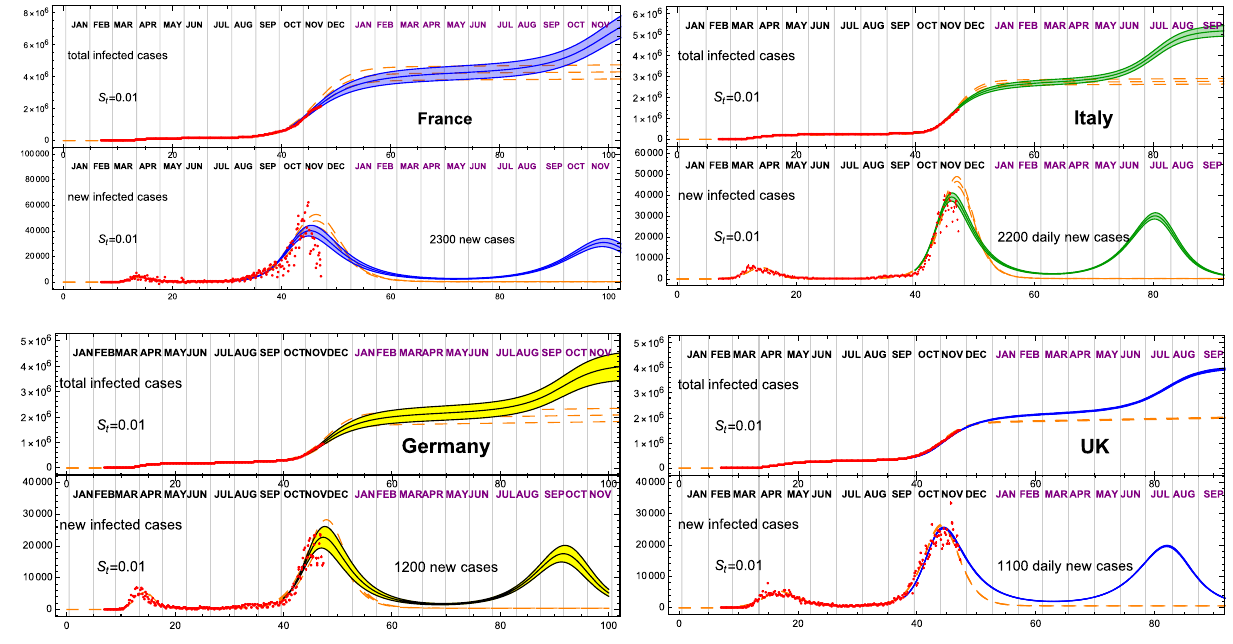
Figure 3. Strolling as a precursor of a COVID-19 third wave. Most European countries are still undergoing a second wave of COVID-19. In this figure we show how a strolling period, consistent on a fixed number of new infections per day (indicated in each panel) could lead to a third wave, as indicated by the solid band. The prediction corresponds to S t = 0.01 , and is compared to the data (adjourned to November 23) and the eRG fit from Table 1 (dashed orange). The plot includes France, Italy, Germany and the UK.